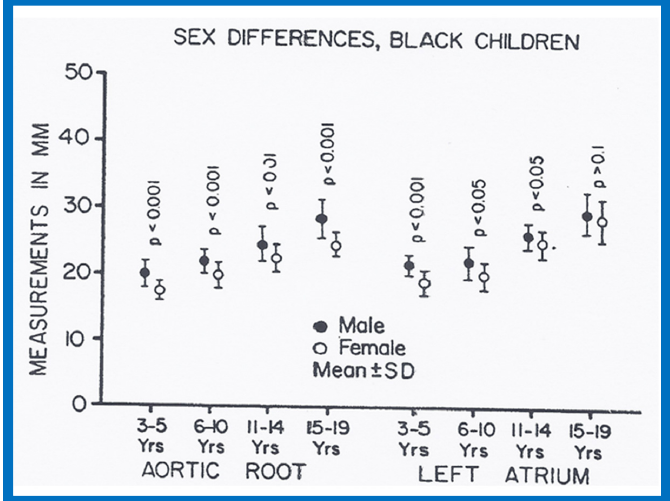
Figure 32. Gender ‐ related differences in the measurements of aortic root and left atrium are illustrated for male black (filled circles) and female black (unfilled circles) children. Means and standard deviations (SD) are shown. Note larger ( p < 0.001) aortic root size in males than females for all age groups. The left atrial size was larger ( p < 0.05 to 0.001) in males than females in most age groups. Reproduced from Rao P.S., Thapar M.K. [10].